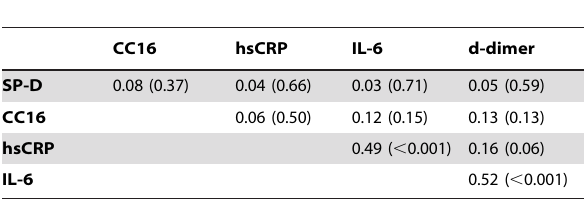
Table 3. Spearman correlation coefficients (p-value) between baseline Club Cell Protein 16 (CC16), Surfactant Protein-D (SP- D), high-sensitivity C-reactive protein (hsCRP), Interleukin-6 (IL-6), and d-dimer for cases and controls